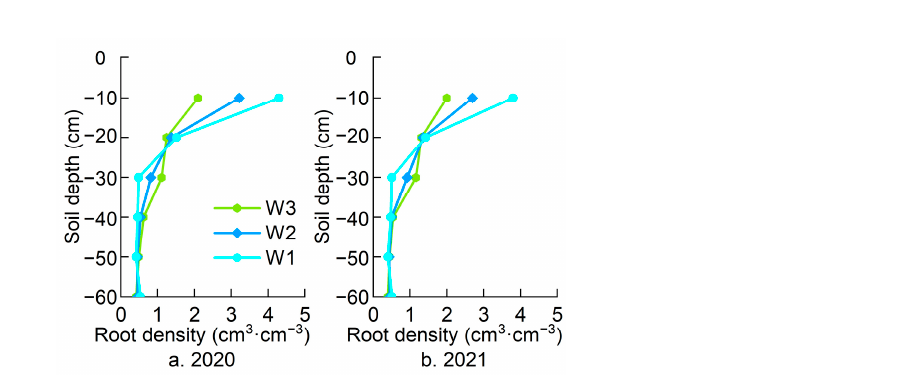
Figure 6. Root density (cm 3 ·cm − 3 ) of tomatoes in the 0–60 cm soil layer under different water treatments, in 2020 and 2021.